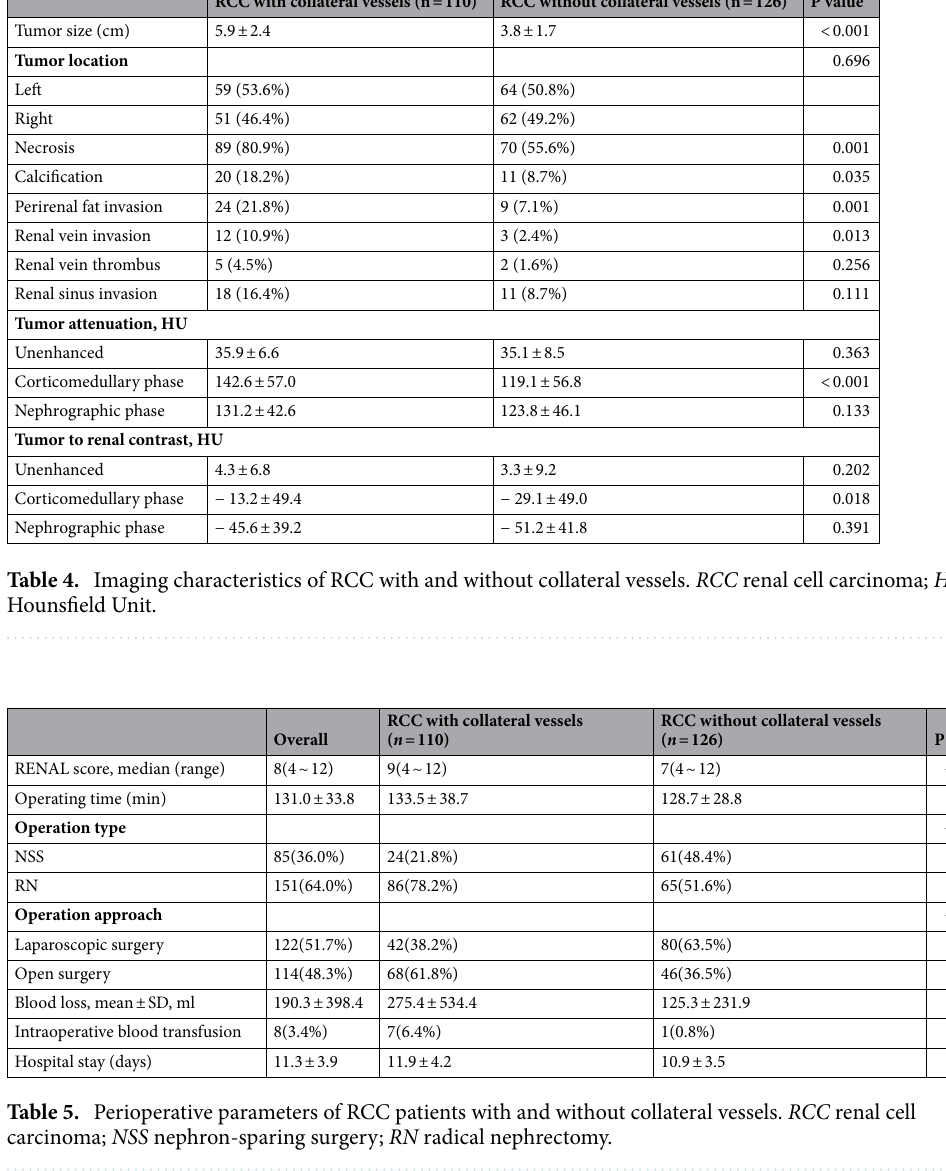
Table 5. Perioperative parameters of RCC patients with and without collateral vessels. RCC renal cell carcinoma; NSS nephron-sparing surgery; RN radical nephrectomy.